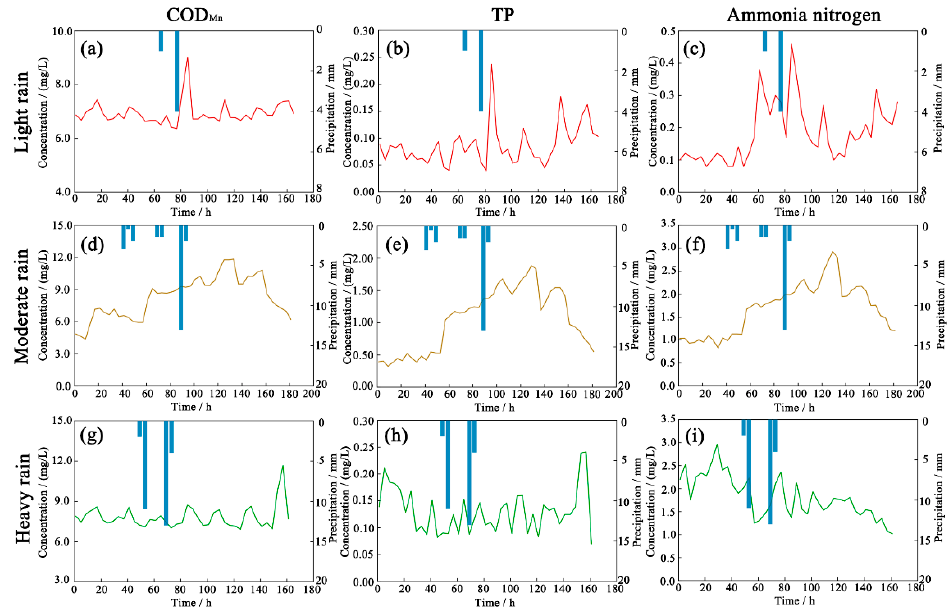
Figure 7. Pollution variation trends under light ( a – c ), moderate ( d – f ), and heavy rain ( g – i